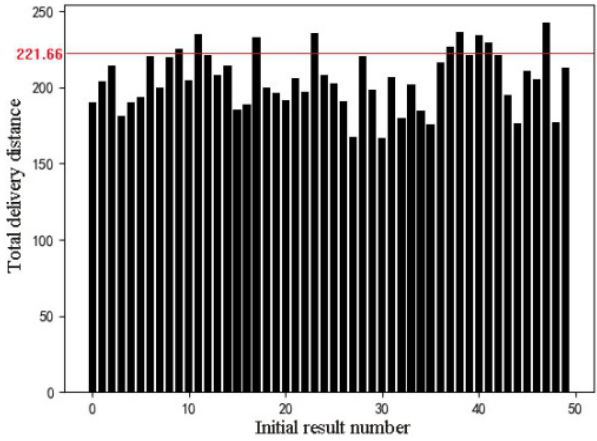
Figure 11. result of the initial solutions of instance 1.